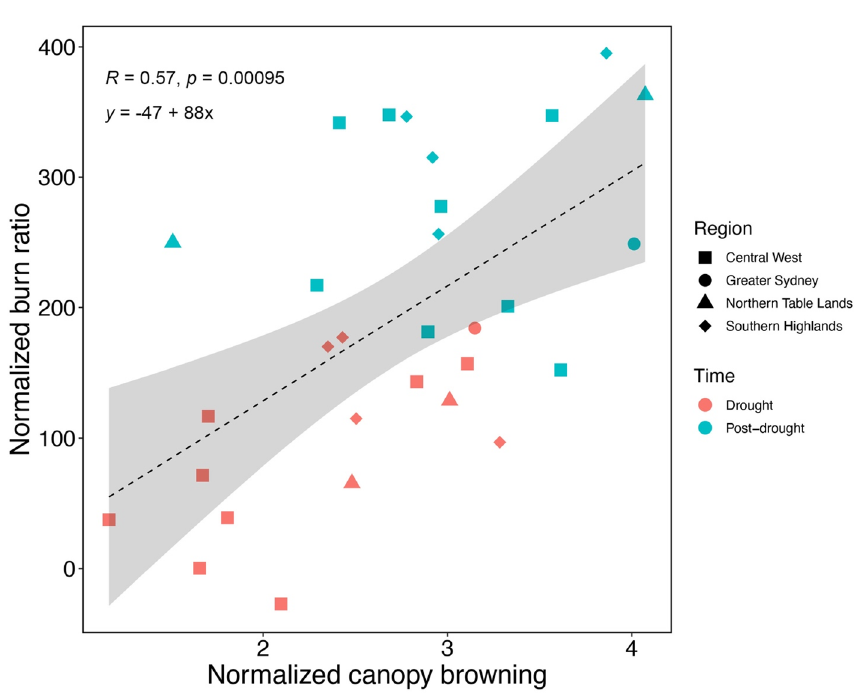
Figure 5. Normalized canopy browning versus normalized burn ratio (NBR) measured at each site during drought (red symbols) and post-drought (light blue symbols). Different symbols indicate the four regions under study: Southern Highlands (diamonds), Central West (squares), Greater Sydney (circles) and Northern Table Lands (triangles). The grey shaded area is the confidence interval of the regression